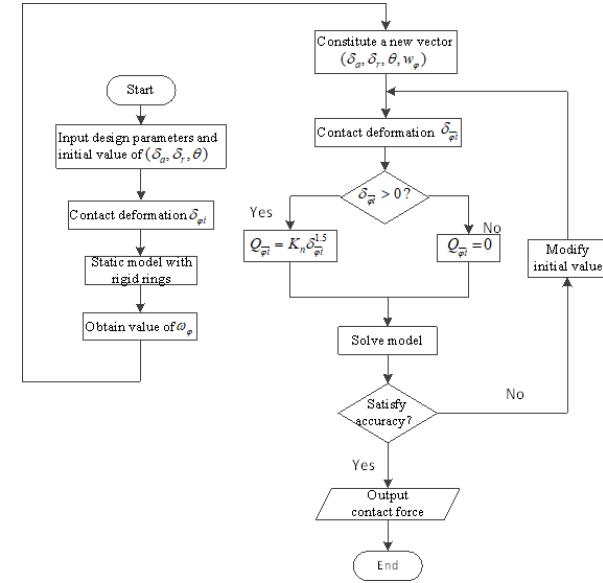
Figure 5: Calculation flowchart of load distribution